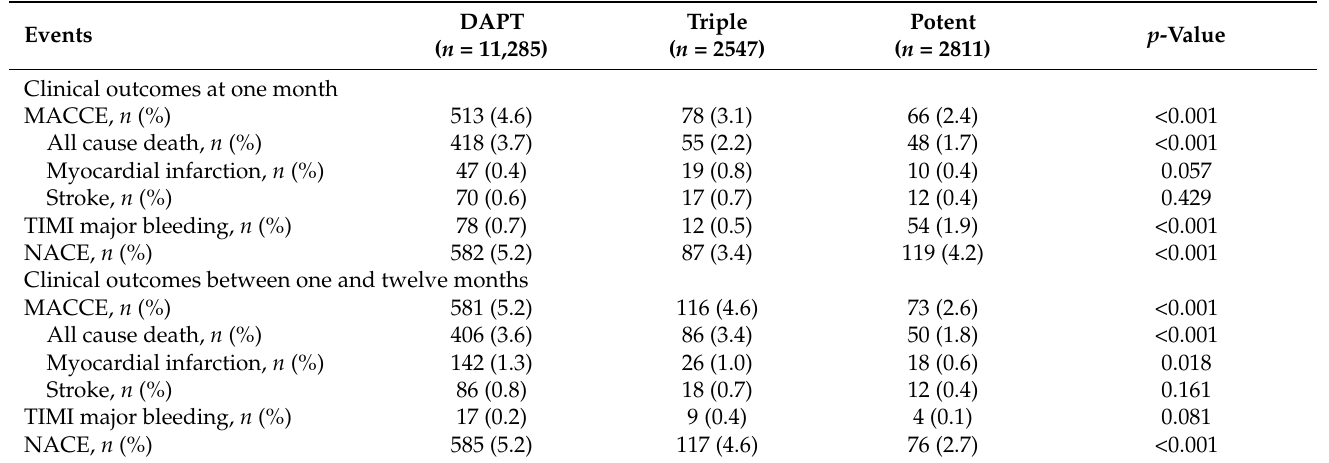
Table 2. Clinical outcomes.